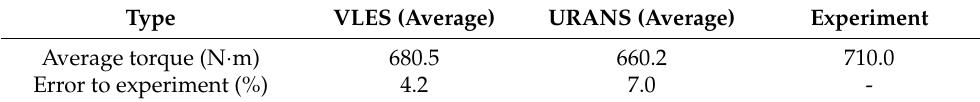
Figure 16. Pressure coefficients of URANS, transient VLES, and experiment (wind speed = 15 m/s). Table 7. Comparison of CFD torque values with experimental data (wind speed = 15 m/s).